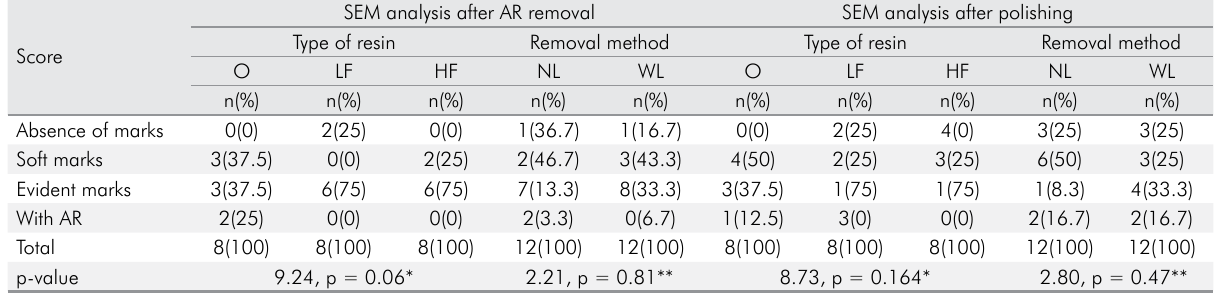
Table 2. SEM assessment after the removal of adhesive remnants (AR) and after polishing, considering the different systems tested (O: Opaque; LF: low fluorescence; HF: high fluorescence) and the methods for removing AR (NL: no UV light; WL: With UV light).